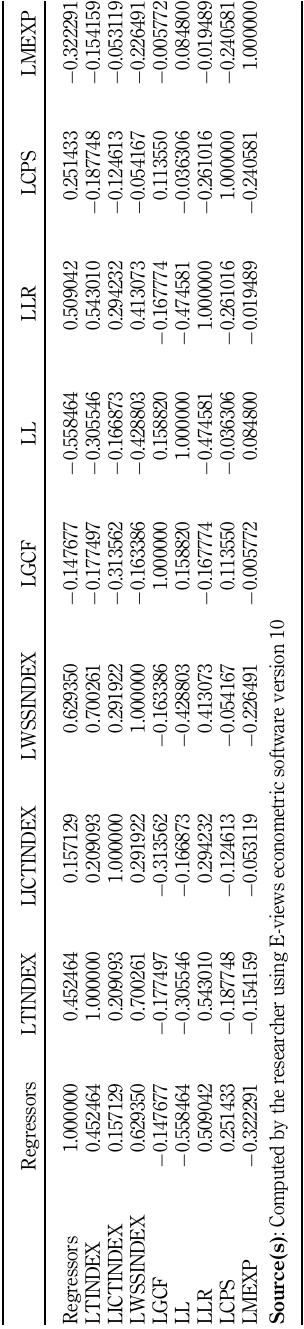
Table V. Result of correlation analysis and multicollinearity